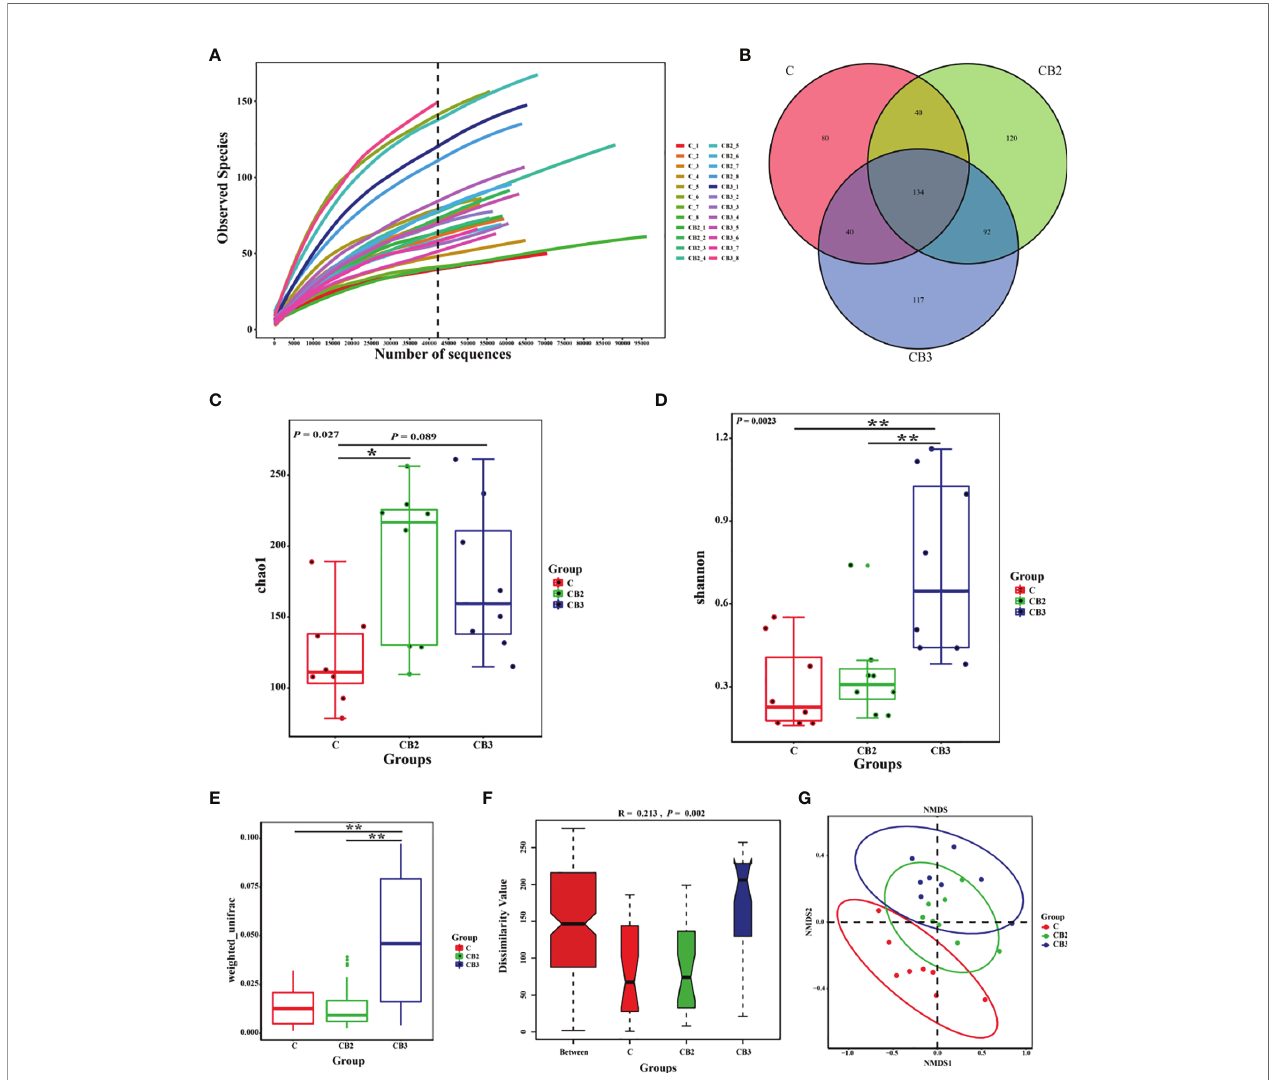
FIGURE 8 | Effects of dietary chitosan oligosaccharides (COS) and Clostridium butyricum synbiotic supplementation on ileal microbiota in early-weaned pigeon squabs. (A) Rarefaction curves. (B) Venn diagram of operational taxonomic units (OTUs). (C) Microbiota richness is represented by Chao1 index. (D) Microbiota diversity is represented by Shannon index. (E) Weighted_unifrac distance. (F) Analysis of similarities based on OTUs. (G) Non-metric multidimensional scaling (NMDS) analysis plot of bacterial communities. Values are means with the SEM of eight squabs. * p < 0.05 and ** p < 0.01. C group, control group, squabs fed